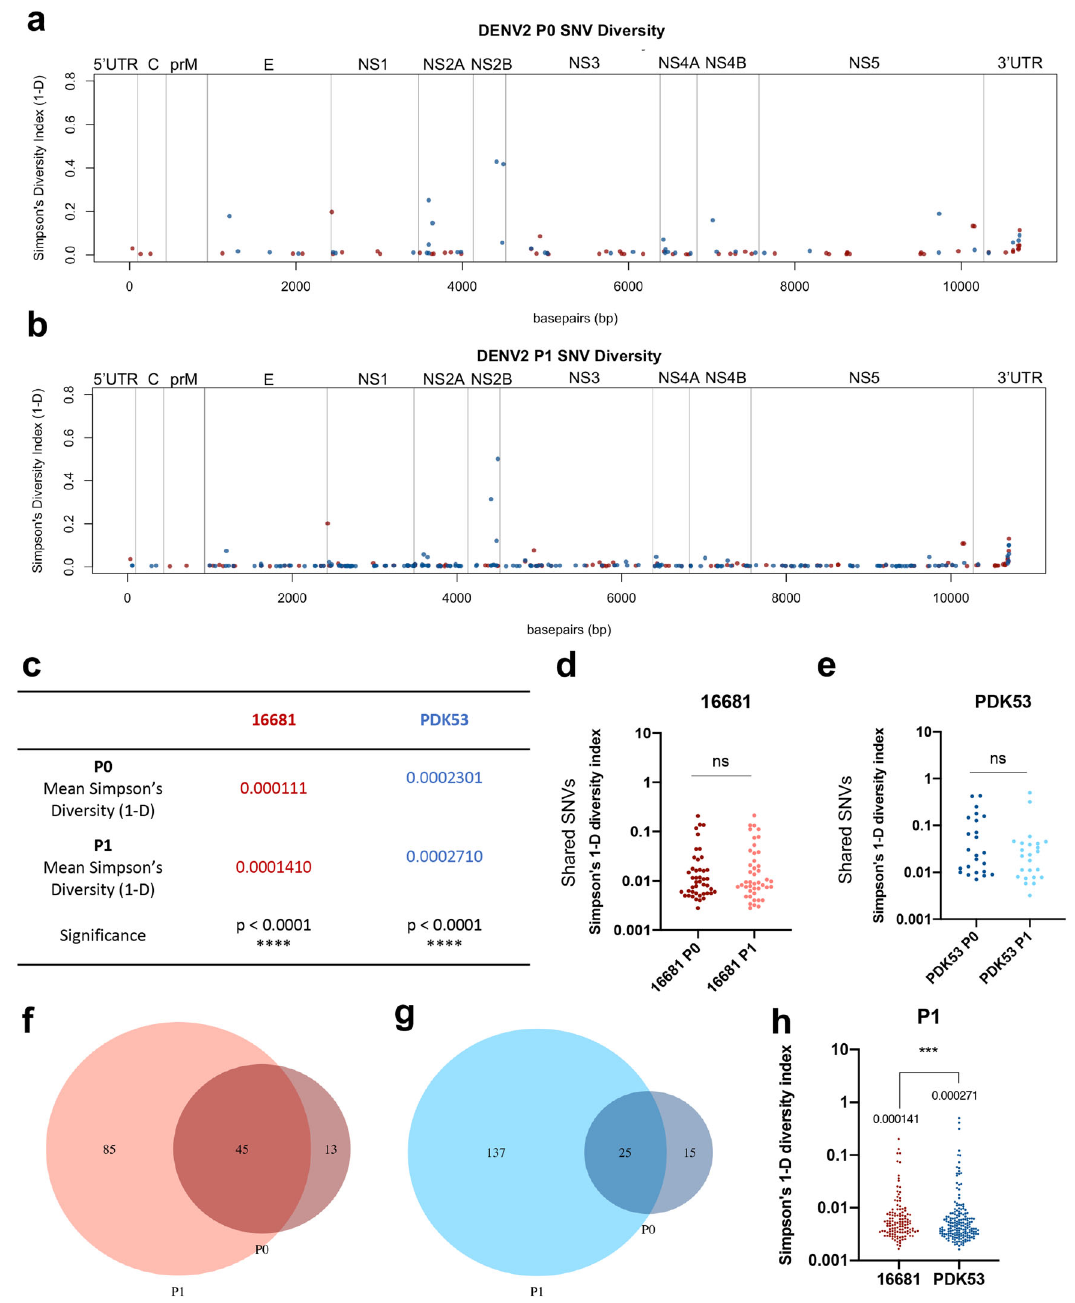
Fig. 2 DENV2 PDK53 infectious clone is more genetically diverse than DENV2 16681 infectious clone. Allele diversity measured by Simpson ’ s index at variant positions along the DENV2 genome of 16681 (red) and PDK53 (blue) at ( a ) passage 0 (P0) and ( b ) passage 1 (P1). c Simpson ’ s diversity of SNVs from 16681 and PDK53 infectious clones at P0 and P1. A Mann – Whitney U test was used to determine signi fi cance. Diversity of overlapping SNV sites between P0 and P1 in ( d ) 16681 and ( e ) PDK53. Statistical signi fi cance was determined using Mann – Whitney U test. Venn diagram of overlapping and novel SNV positions in DENV2 ( f ) 16681 and ( g ) PDK53 between P0 and P1. h Whole genome diversity of DENV2 16681 (red) and PDK53 (blue) infectious clone at P1. The mean diversity is shown above the respective data set. Statistical analysis between the two genomes was performed using Mann – Whitney U